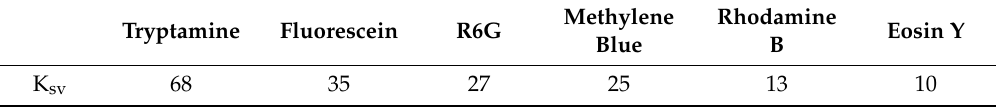
Figure 6. Fit of F 0 / F verse [AgNP] plot of dye molecules in the case of 10 µ M. Error bars are removed for a better comparison. Table 4. Stern-Volmer fit results (K sv in nM − 1 of [AgNP]) with the concentration of the dyes at 10 µ